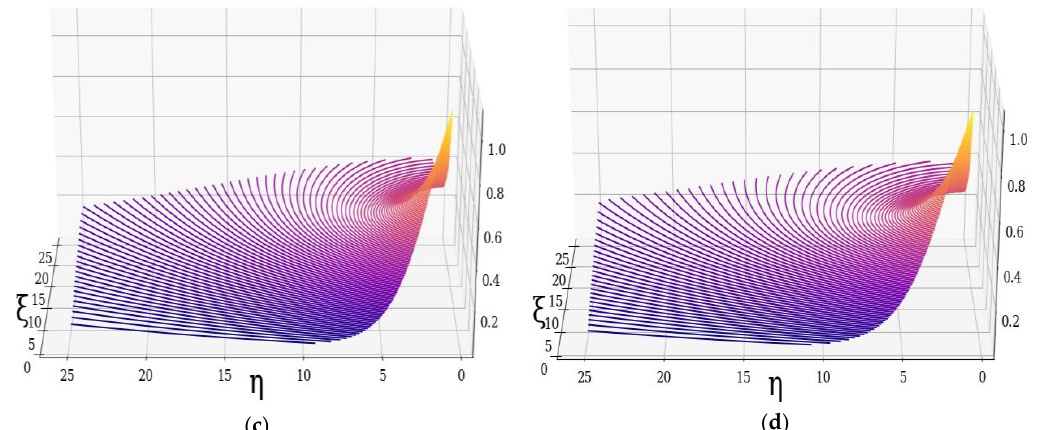
Figure 1. Dimensionless velocity field U of non-differentiable atmospheric multifractal: ( a ) ν = 0.5 , ( b ) ν = 1 , ( c ) ν = 1.5 , ( d ) ν = 2 .